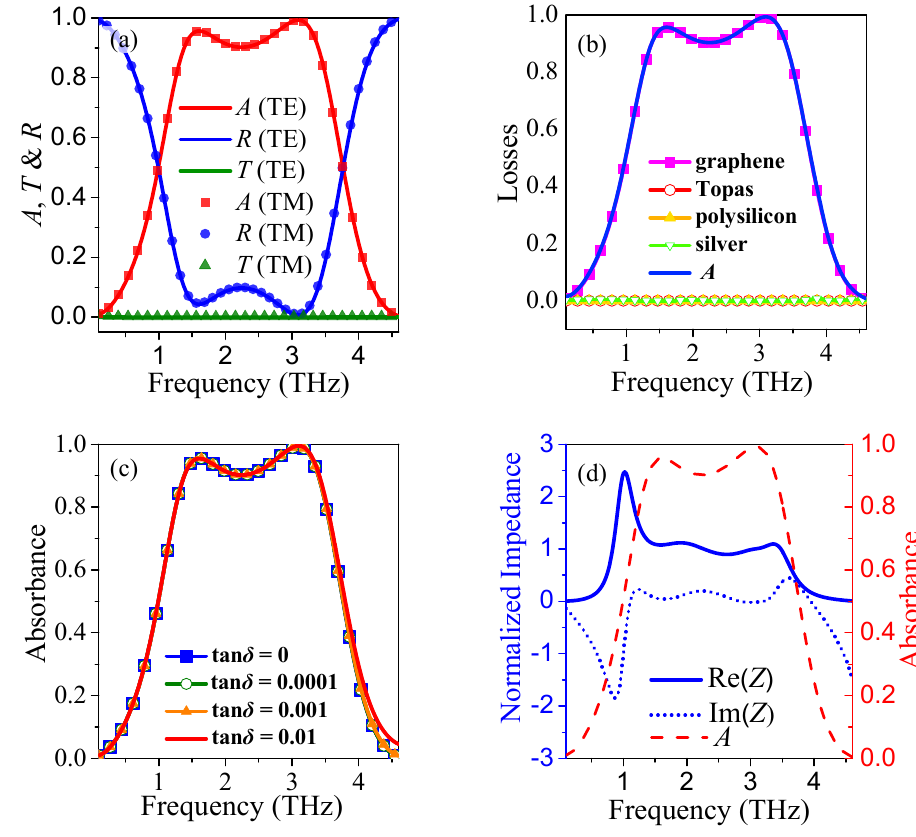
Figure 2. ( a ) Simulated reflection ( R ), transmission ( T ), and absorbance ( A ) of the proposed absorbers for both TE and TM polarizations at μ c = 0.7 eV under normal terahertz incidence; ( b ) Simulated surface and volume losses of the different materials of the proposed absorber; ( c ) Absorption spectra of the proposed absorber with different loss tangents tan δ = 0, 0.0001, 0.001, and 0.01 for both Topas and polysilicon; ( d ) Retrieved effective impedance ( Z ) of the proposed absorbers, where the blue solid curve and the blue dash-dot curve represent the Re( Z ) and Im( Z ), respectively, and the red dash curve is the absorption spectrum that is presented for contrast.